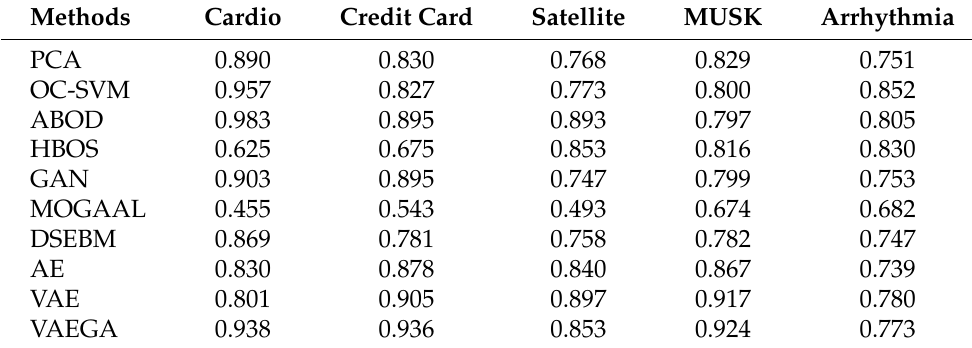
Table 5. Recall of 10 models for outlier detection on 5 datasets.